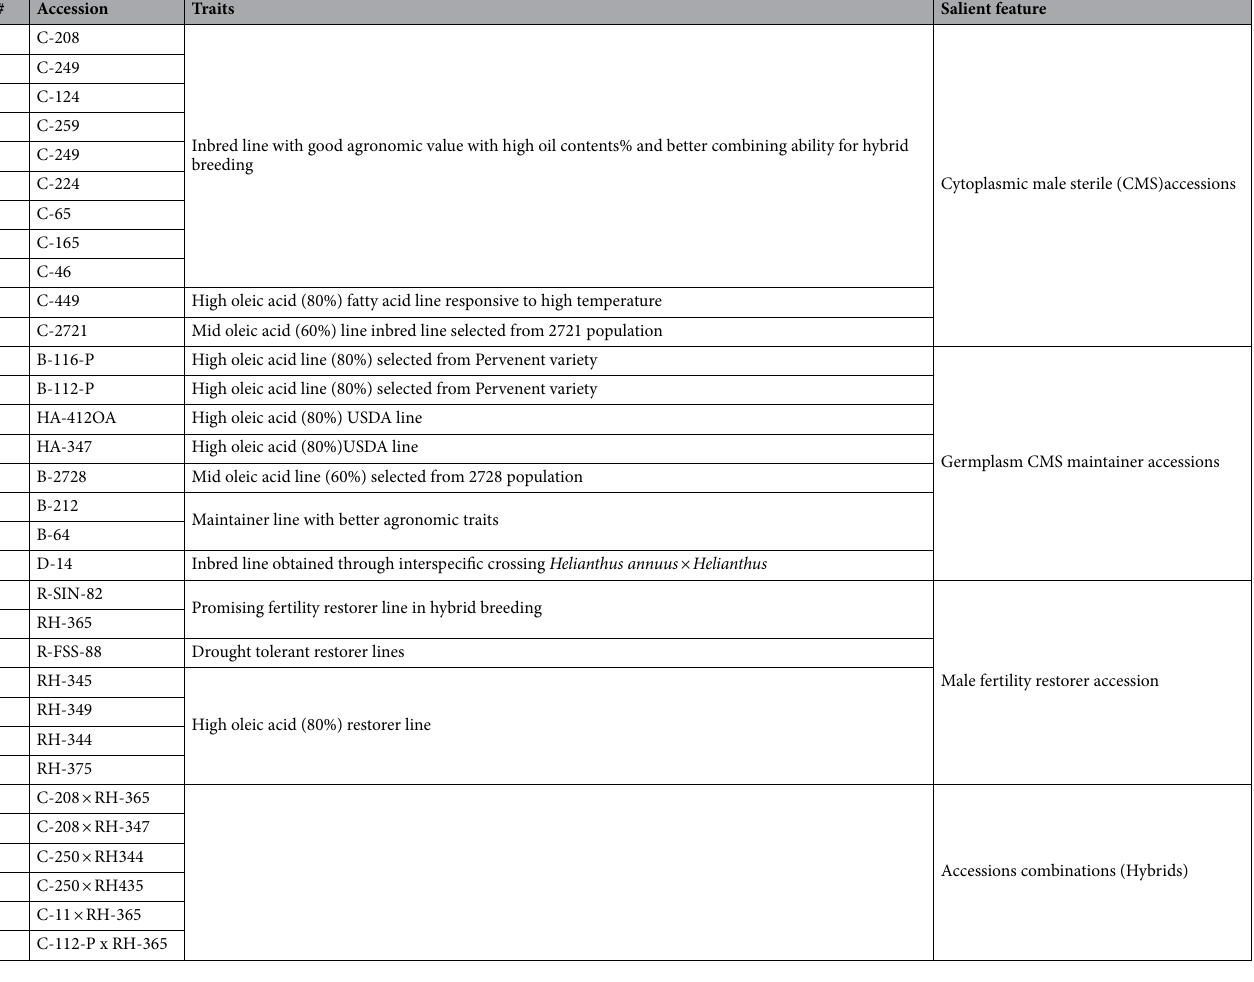
Table 5. List of accessions used in